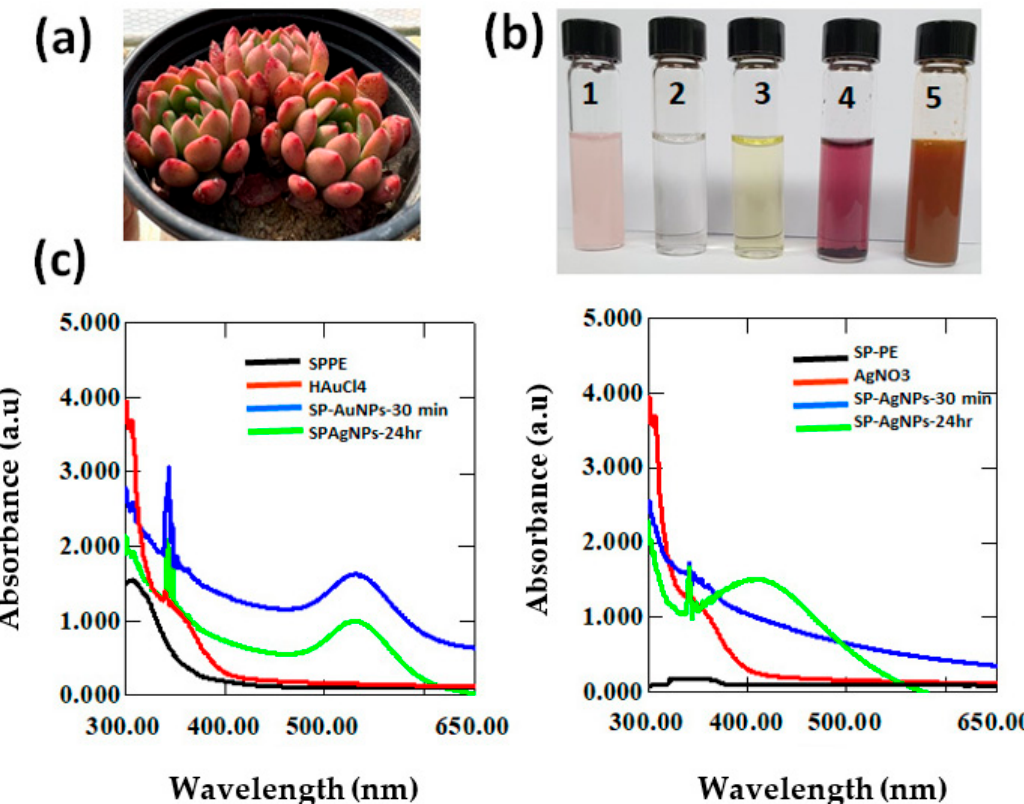
Figure 1. UV–Vis spectra of SP-mediated AuNP and AgNP colloidal solution measured at different time intervals (30 min over 24 h). ( a ) Photographs of Sedeveria pink ruby plant. ( b ) Colors of solutions indicating the redox reaction ((1) SP aqueous plant extract, (2) AgNO 3 , (3) HAuCl 4 , (4) SP-AuNPs, and (5) SP − AgNPs). ( c ) UV–Vis spectra of AuNPs and AgNPs exhibiting λ max at 531 and 410 nm, respectively.